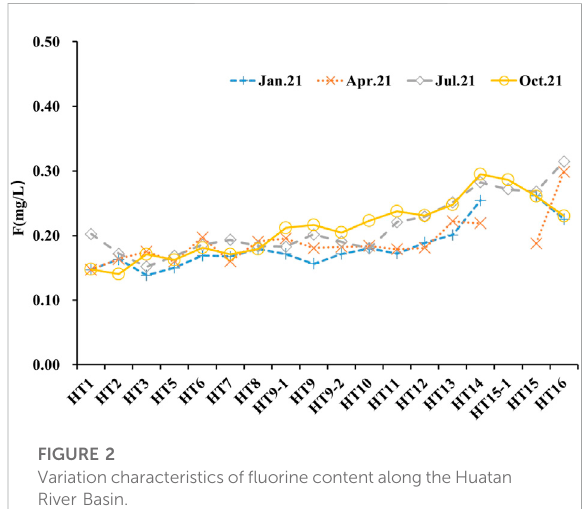
FIGURE 2 Variation characteristics of fl uorinecontent alongthe Huatan River